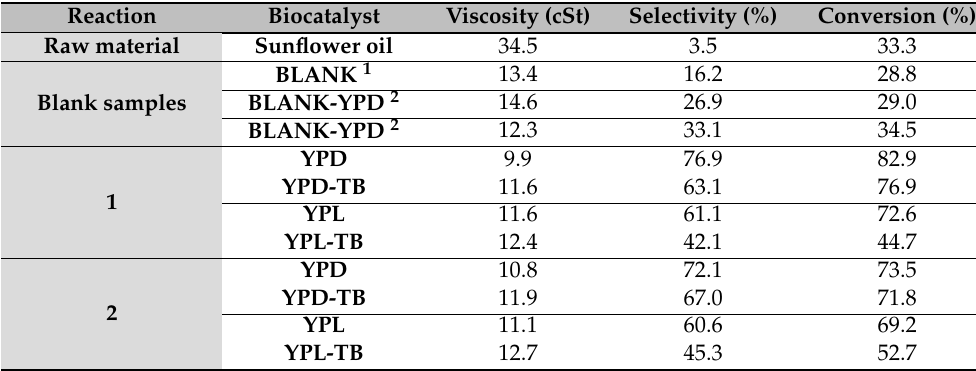
Table 3. Transesterification reaction yields obtained operating under standard reaction conditions: 6 mL of sunflower oil, 1.75 mL of ethanol, 30 ◦ C, 25 µ L of 10 N NaOH solution, higher stirring than 300 rpm, during 24 h of reaction time. As a biocatalyst is applied 0.5 g of enzymatic extract of standard CA strain from the CECT, obtained from several broths media obtained as it is indicated in Figure 2. The results obtained when repeating the reactions are presented. Viscosity (cSt) values of different reaction products obtained are also